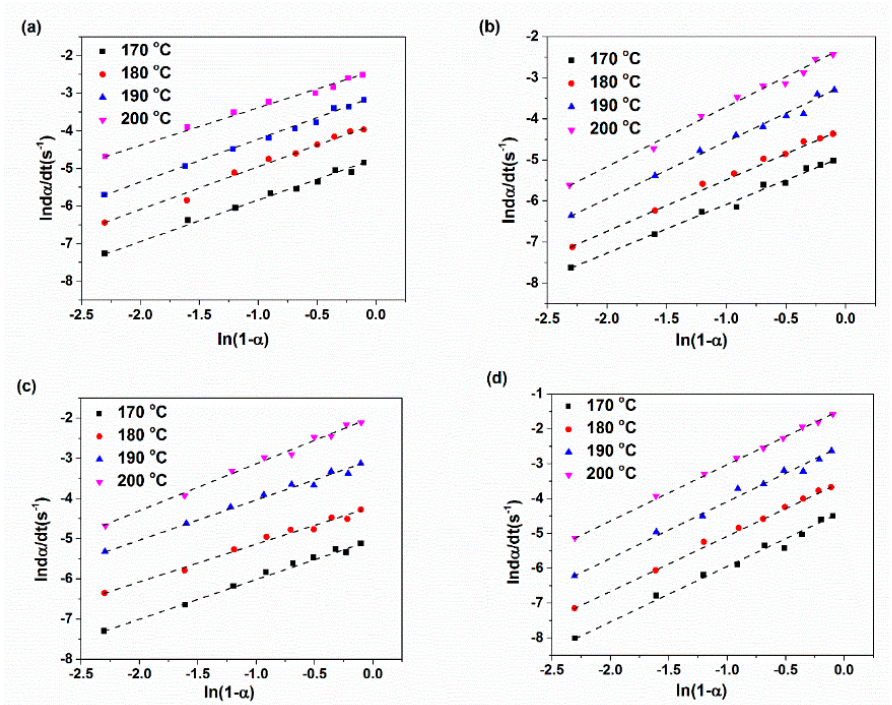
Figure 5. Plots of ln(d α /dt) vs. ln(1- α ) for various XNBR/epoxy/XHNT nanocomposites based on n th order model for: ( a ) XE15; ( b ) XE15H3; ( c ) XE15H5; ( d ) XE15H7.